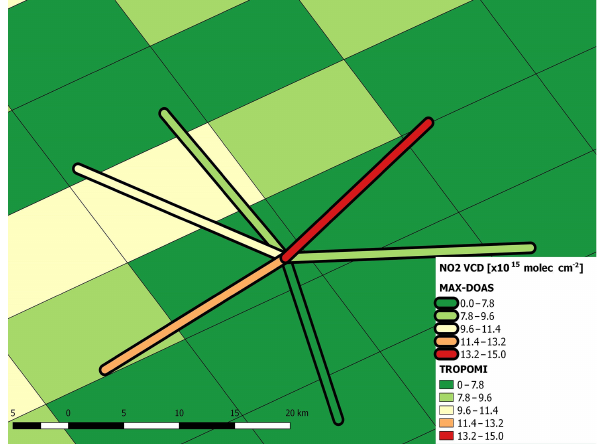
Figure 7. Tropospheric NO 2 columns derived from TROPOMI (pixel size equal to 7 × 3 . 5km 2 ) and the MAX-DOAS instrument on 6 June 2018 near the measurement site of